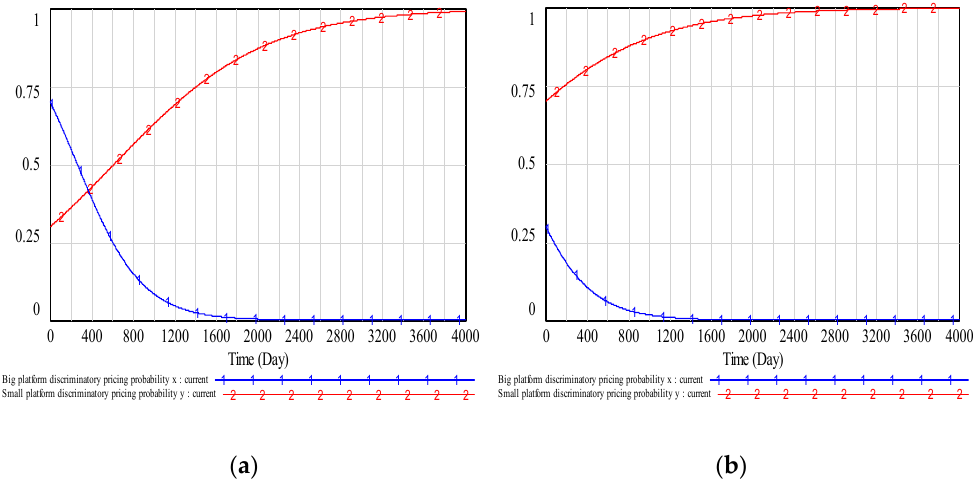
Figure 3. The dynamic evolution paths of case ② . ( a ) The initial proportion pair of both types of platforms is (0.7,0.3) . ( b ) The initial proportion pair of both types of platforms is (0.3,0.7) .